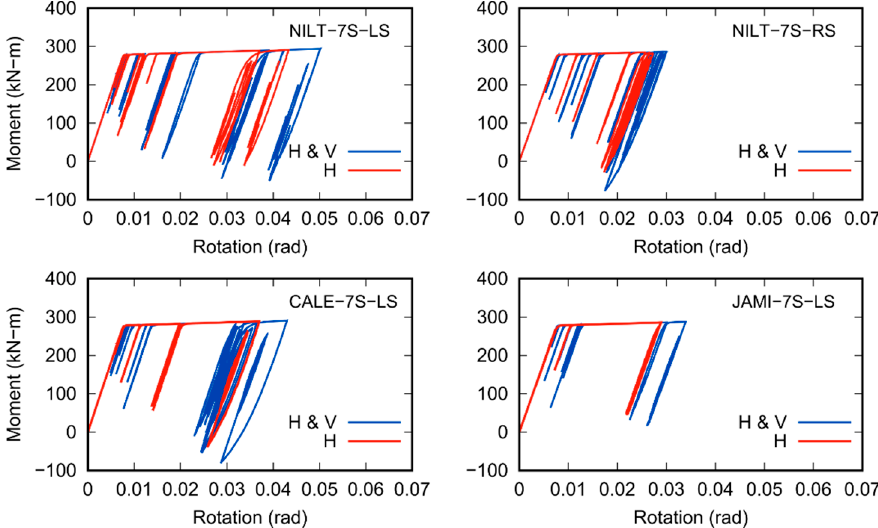
Figure 21. Non-linear response of the outer-most fiber in the considered beam for different earth- quakes; 8-story building (Part 1).